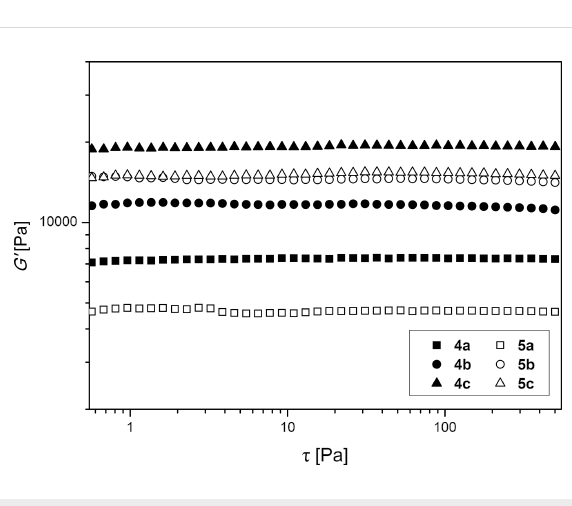
Figure 3: Storage modulus G’ as function of applied shear stress τ for samples 4 and 5 containing different amounts of CL 1 or CL 2 .